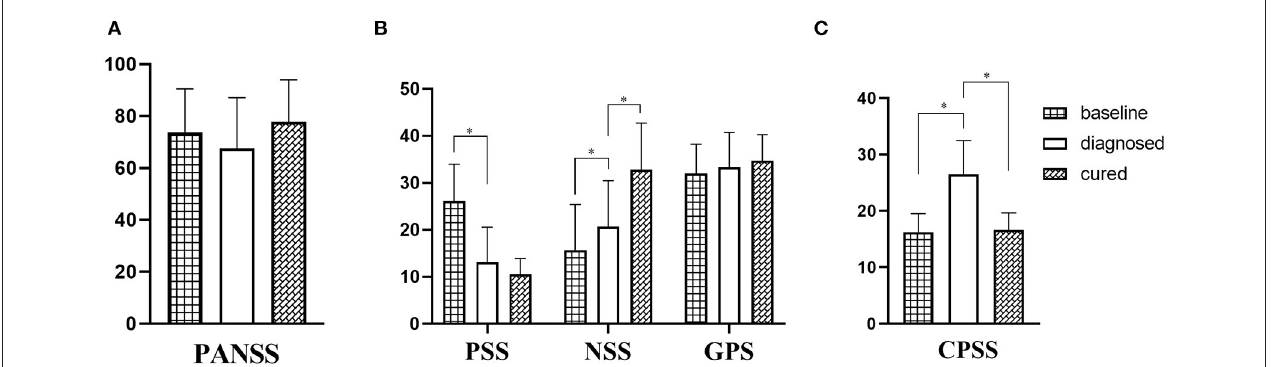
FIGURE 1 | (A) Comparison of PANSS scores at three time points. There is no statistical difference in PANSS score at different time. (B) Comparison of PANSS subscale scores at three time points. The PSS score was significantly lower at the time of diagnosis than at the baseline. The NSS score at diagnosed is significantly higher than at baseline and significantly lower than at cured. There is no difference in GPS scores at different time. (C) Comparison of CPSS scores at three time points. The CPSS score at the time of diagnosed is significantly higher than that at baseline and cured.